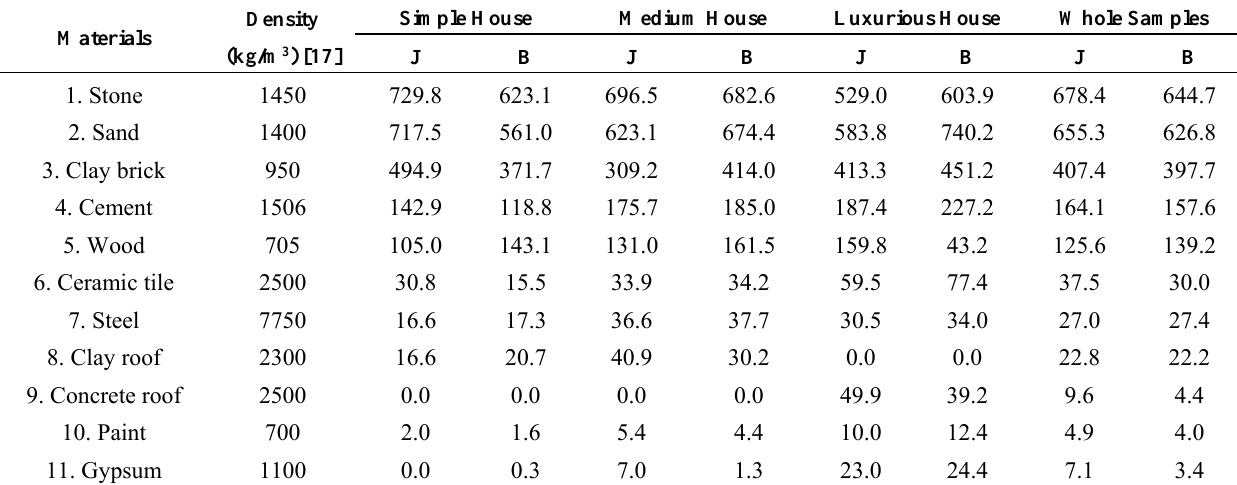
Table 4. Current building material inventory (unit: kg/m 2